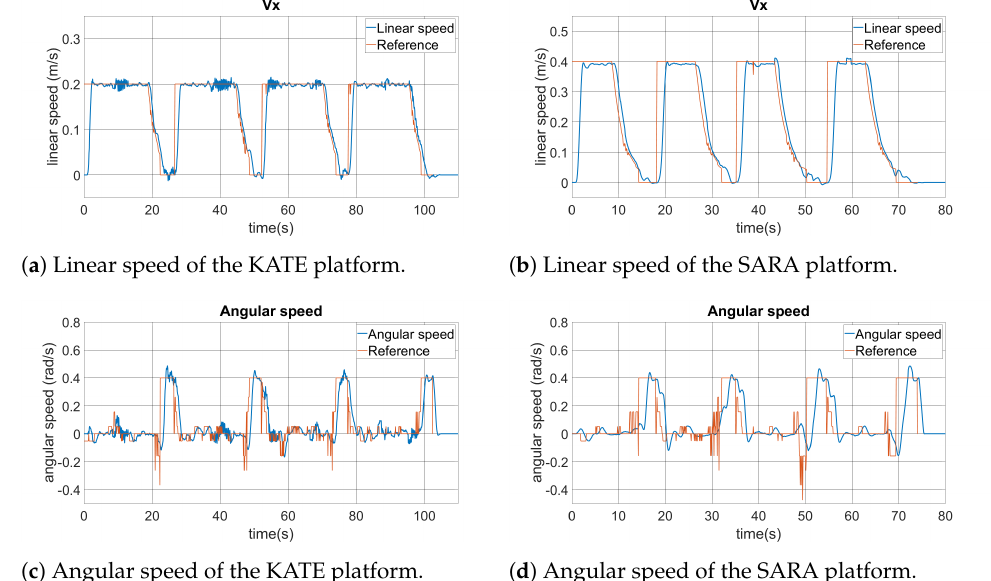
Figure 21. Comparison of the KATE and SARA platforms’